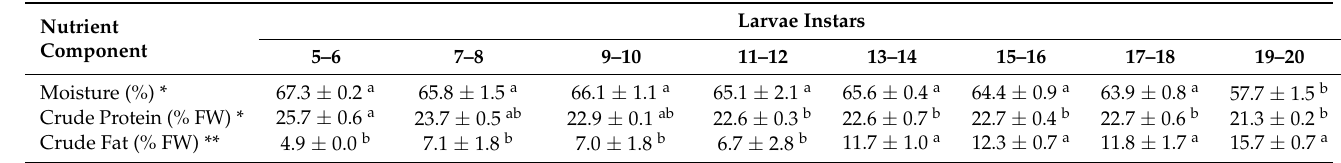
Table 1. Nutritional composition of Tenebrio molitor larvae of different larval instars (5 to 20) on a fresh weight (FW) basis (%). Data are presented as mean ± standard deviation, * n = 6, ** n = 4.